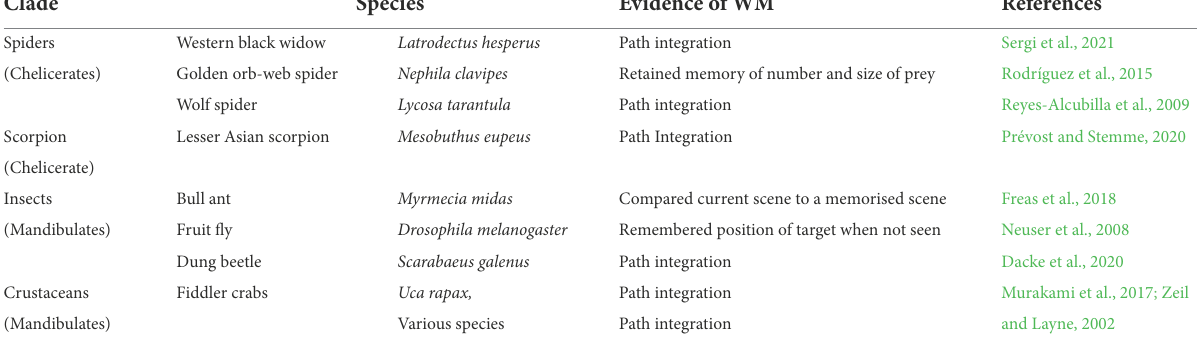
TABLE 2 Some arthropods with